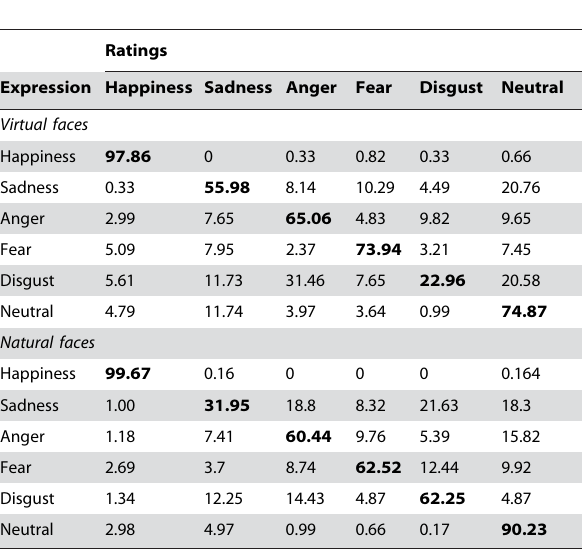
Table 2. Accuracy ratings and confusions (% correct) for virtual and natural faces.